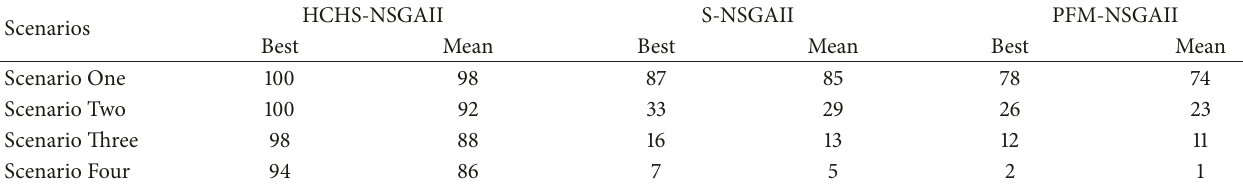
Table 1: The rates of the feasible solutions (%).